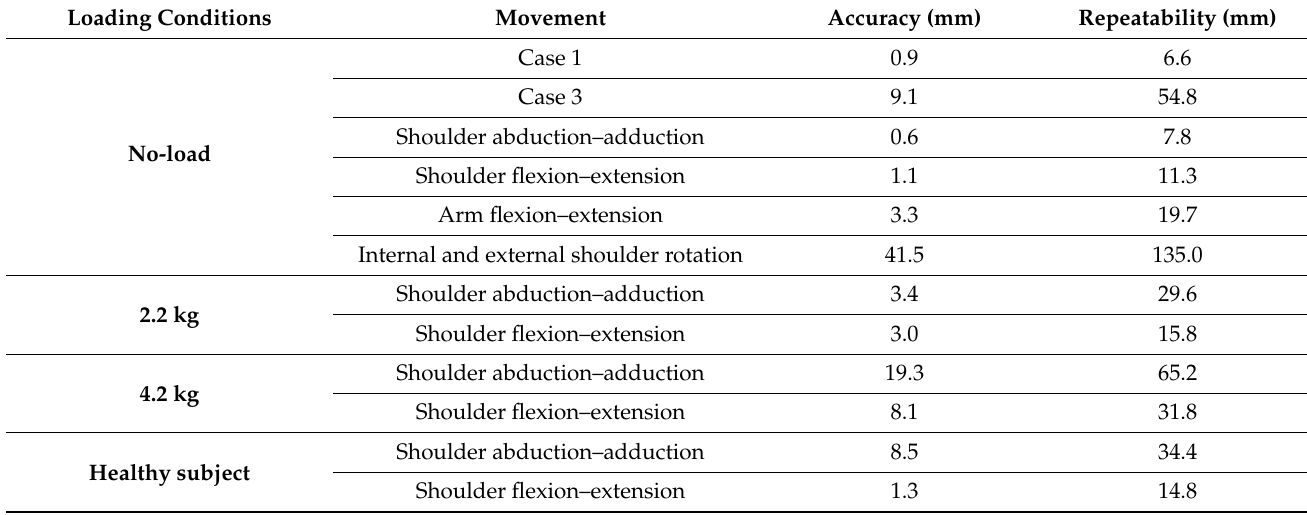
Table 8. Accuracy and repeatability in ERMIS trajectories.